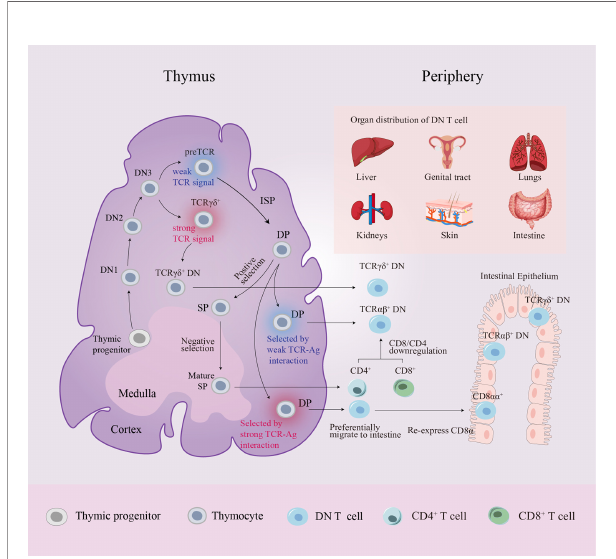
FIGURE 1 | Schematic diagram of DN T cell origin and distribution. Progenitor cells from the bone marrow colonize the corticomedullary junction of the thymus and generate the T cell lineage. In the DN3 stage, generally, high TCR strength makes TCR gd + DN thymocytes remain “ double-negative ” , whereas low TCR strength induces DN thymocytes with pre-TCRs to follow the ab lineage fate. A small number of DP thymocytes differentiate into two distinct mature DN thymocyte subsets rather than entering the late SP stage: DN thymocytes selected by very strong TCR-MHC interactions preferentially migrate to the intestine where they re-express CD8 a and are sequestered as CD8 aa + intraepithelial lymphocytes, while DN thymocytes selected by very weak TCR-MHC interactions become precursors to peripheral TCR ab + DN T cells. In peripheral circulation, CD4 + /CD8 + T cells can also convert into DN T cells by downregulating CD4/CD8 expression. Peripheral DN T cells are localized in various organs in mice and humans. ab , alpha and beta; Ag, antigen; DN, double-negative; DP, double-positive; gd , gamma and delta; ISP, immature single-positive; MHC, major histocompatibility complex; SP, single- positive; TCR, T cell